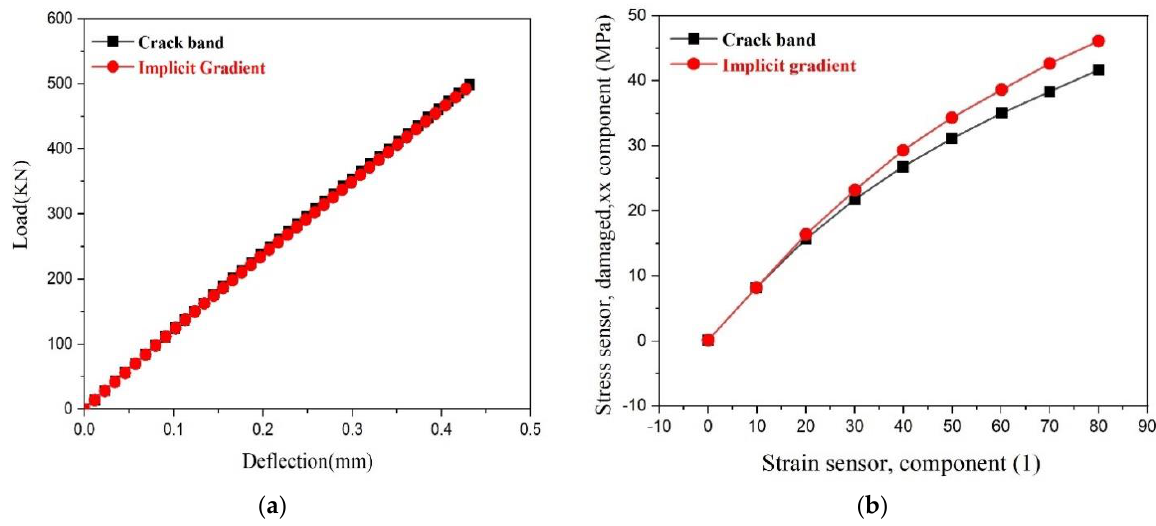
Figure 10. ( a ) Crack trajectories comparison for the single edge angled crack. ( b ) Variation of the stress-strain sensor.